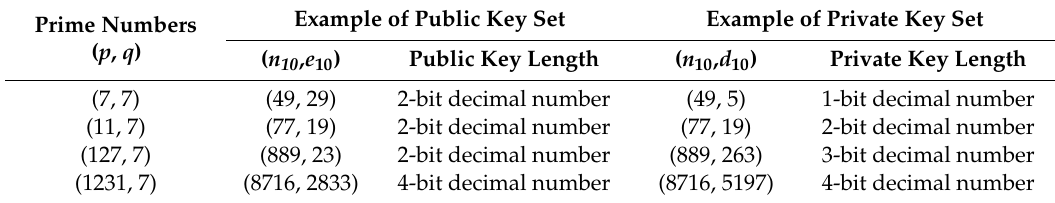
Table 3. Public and private key sets depending on various p prime